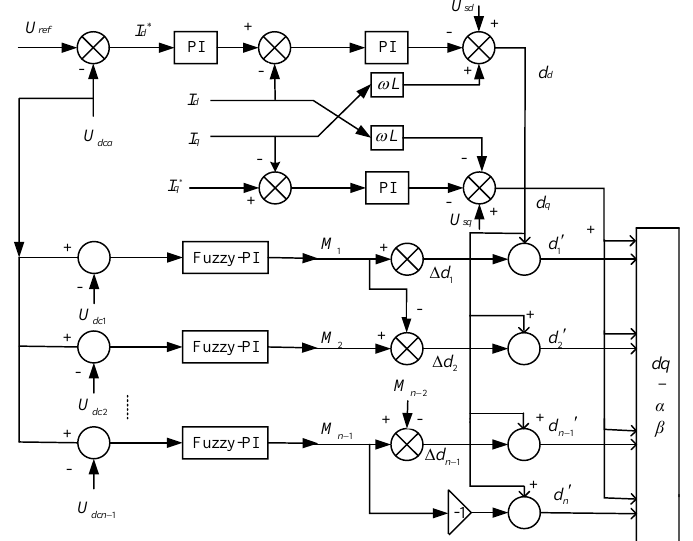
Figure 3. Block diagram of system control strategy.